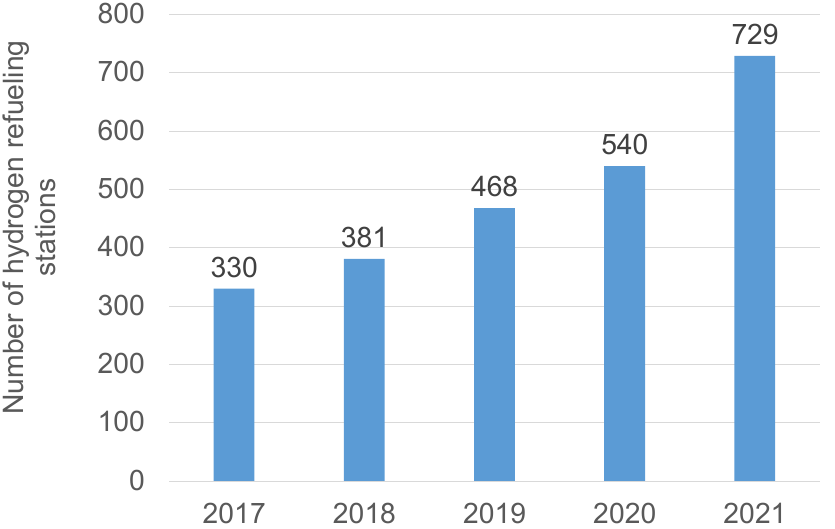
Figure 12. Development of the number of HRSs based on the results from previous surveys and this work.